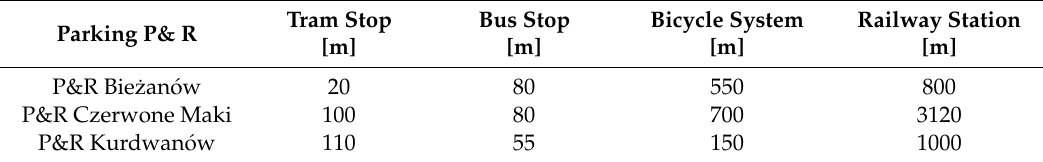
Figure 4. P&R parking in Cracow; (a) example of parking location marking: (b) devices of the Ticket Control System and the Toll Collection System.